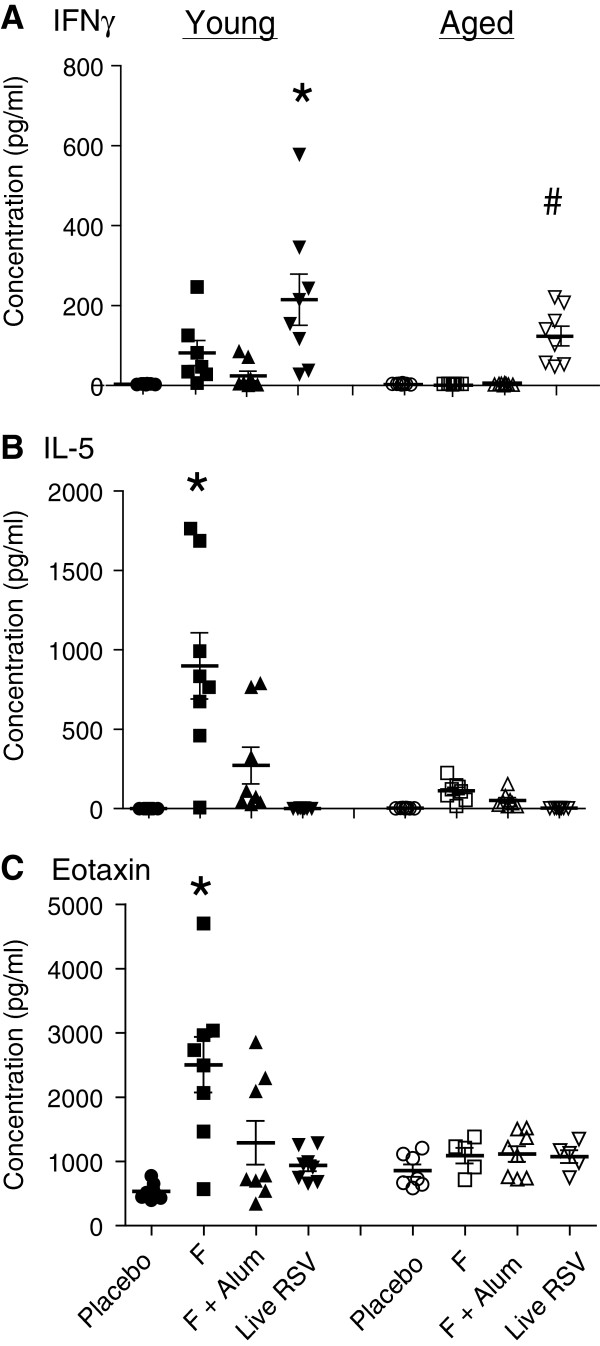
Cytokine levels in the lung homogenates. Cytokines and chemokines in lung homogenates isolated 4 days post-challenge were measured using a 15-plex bead array panel (Luminex). Shown are representative TH1 (IFNγ), TH2 (IL-5) cytokines, and eotaxin levels. (A) IFNγ levels. *, P < 0.05 comparing RSV to placebo, F, or F + alum in young mice (ANOVA). #, P < 0.05 comparing RSV to placebo, F, or F + alum in aged mice (ANOVA). (B) IL-5 levels. *, P < 0.05 comparing F to F + alum in young mice (ANOVA). (C) Eotaxin levels. *, P < 0.05 comparing RSV to placebo, F, or F + alum in young mice (ANOVA).